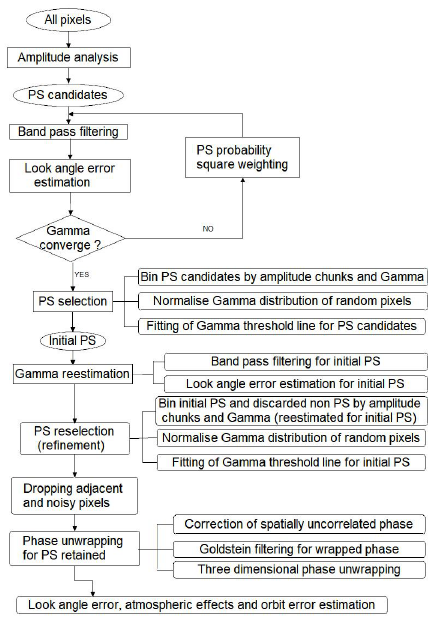
Figure 1. StaMPS technique flow chart